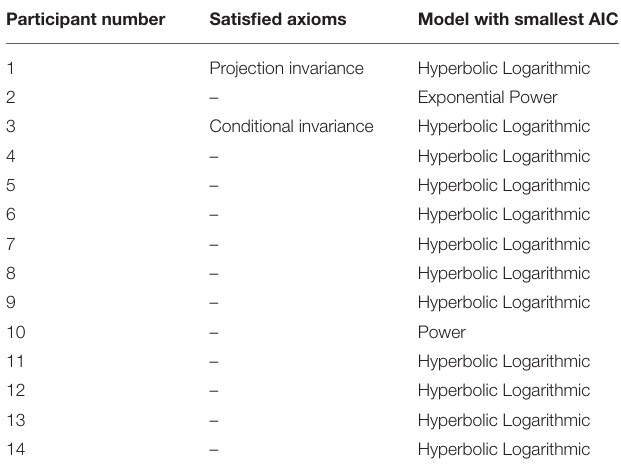
TABLE 11 | Relations between satisfied axioms and models with goodness of